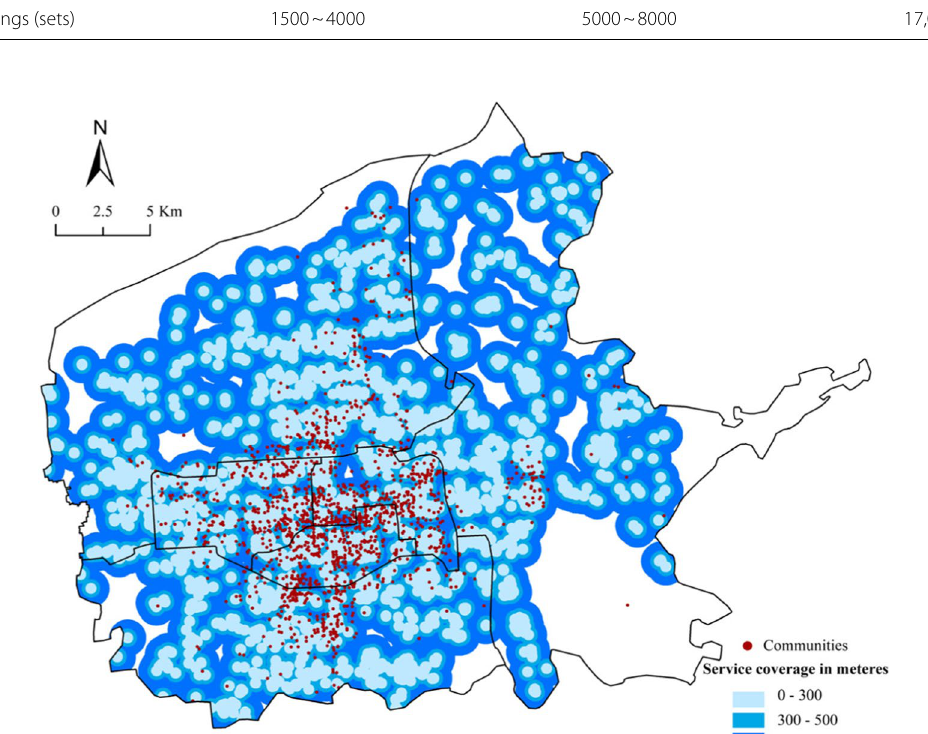
Fig. 6 Various accessibility modes in terms of service coverage area by